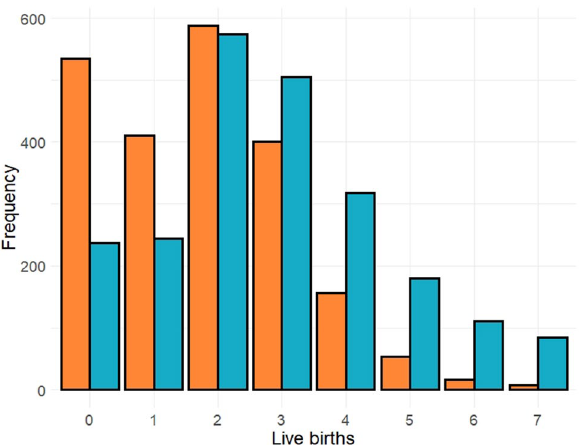
Figure 2. Distribution of live births for pre-menopausal (orange bars; n = 2166) and post-menopausal (blue bars; n =